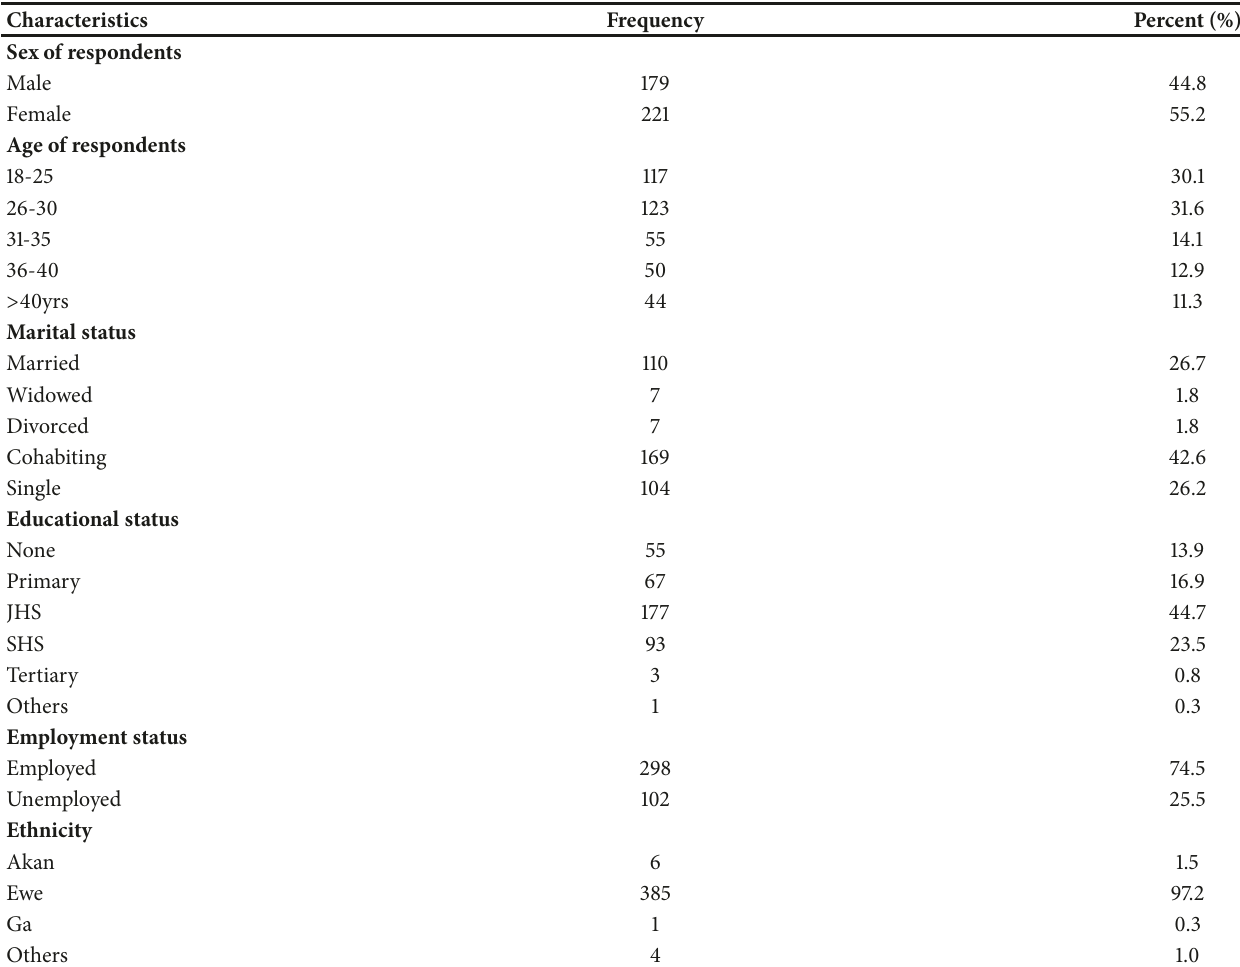
Table 1: Sociodemographic characteristics of respondents.